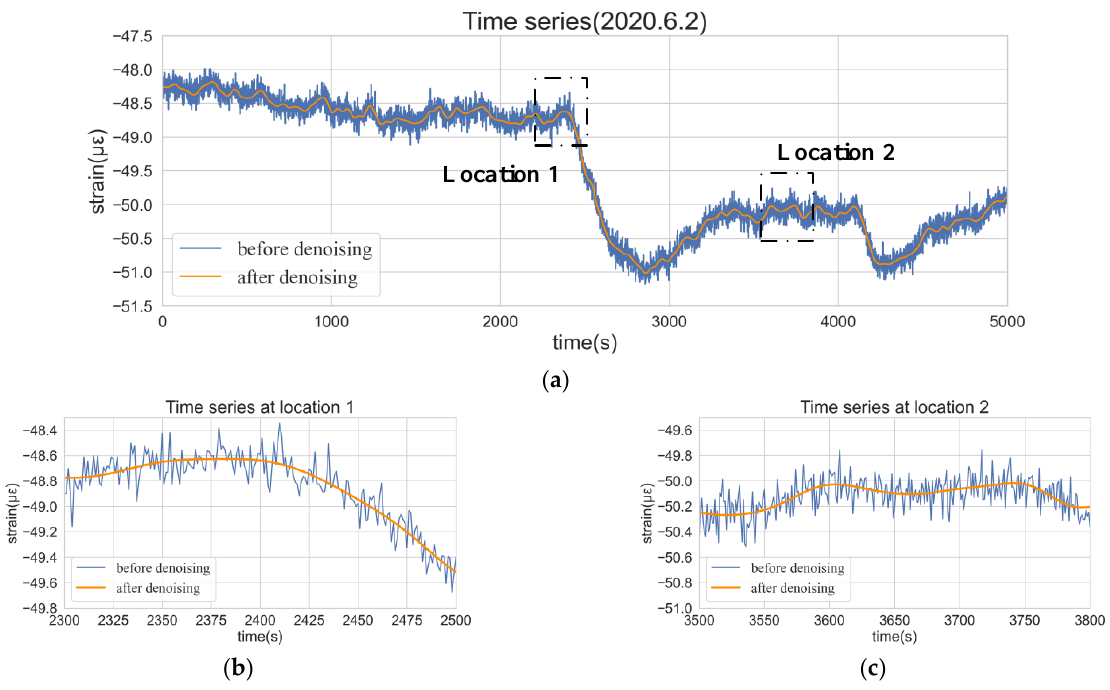
Figure 7. Time series before and after denoising: ( a ) A global version; ( b ) A larger version at location 1; ( c ) A larger version at location